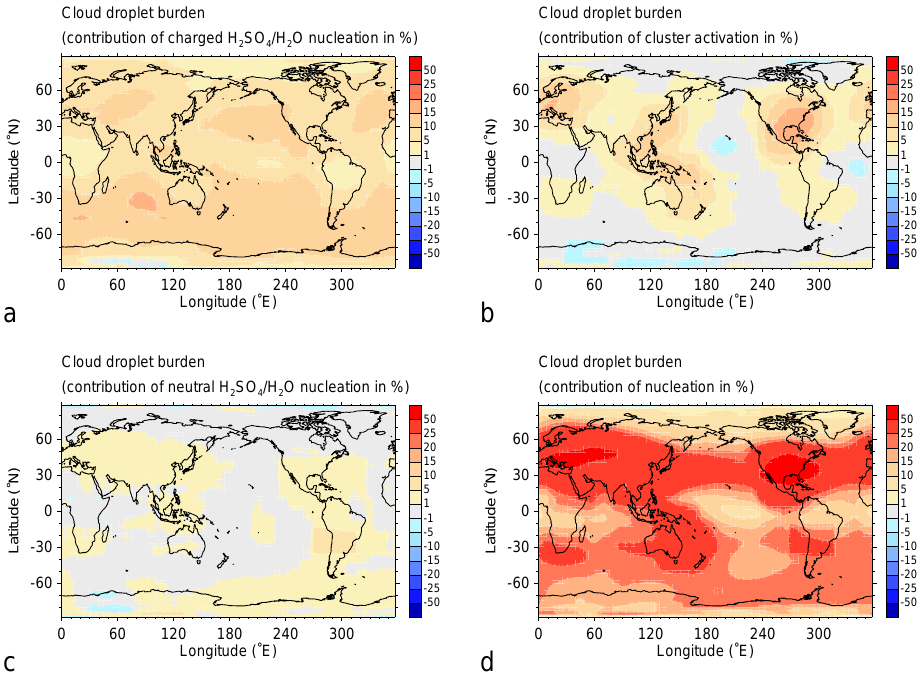
Fig. 10. Contribution of (a) charged H 2 SO 4 /H 2 O nucleation, (b) cluster activation, (c) neutral H 2 SO 4 /H 2 O nucleation, and (d) all nucleation in simulation S ref to the annual mean cloud drop burden. The data were smoothed using a box-shaped, area-weighted low-pass filter covering four latitude and eight longitude points.